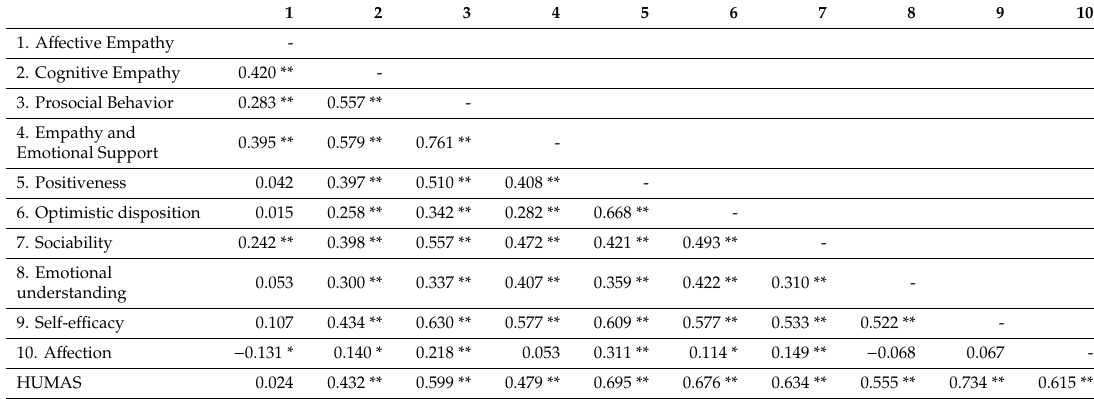
Table 3. Correlations. Convergent analysis of HUMAS.